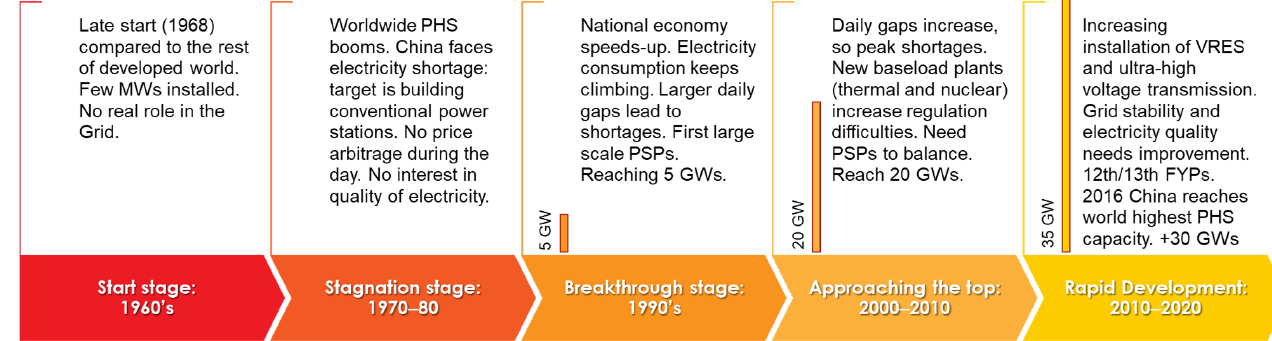
Figure 8. The five stages of PHS development in China.